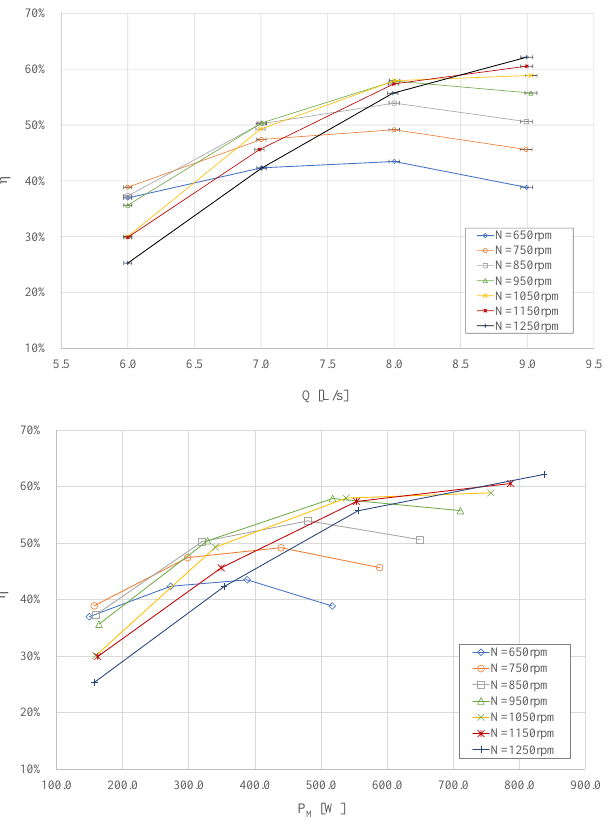
Figure 9. PAT efficiency vs. discharge ( top ) and vs. mechanical power ( bottom ). Each curve refers to a specific rotational speed N